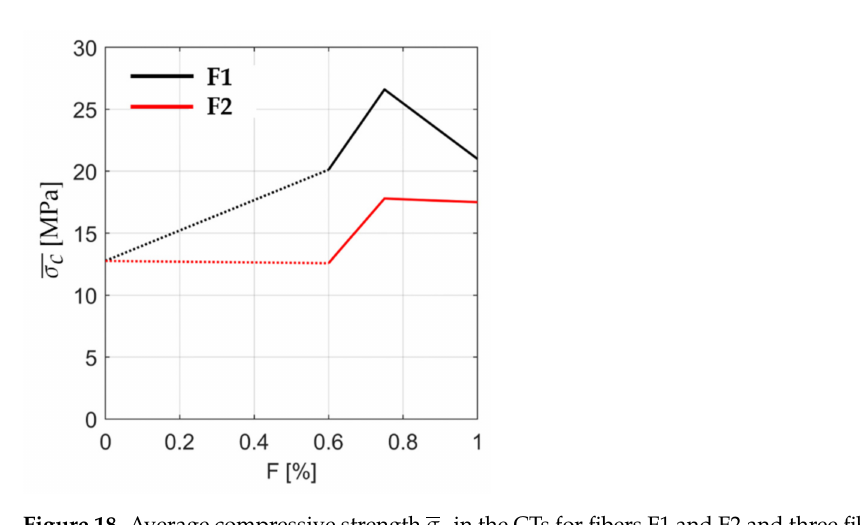
Figure 18. Average compressive strength σ c in the CTs for fibers F1 and F2 and three fiber contents, F . The results obtained in the CTs confirm the trend given by the bending and tensile strength